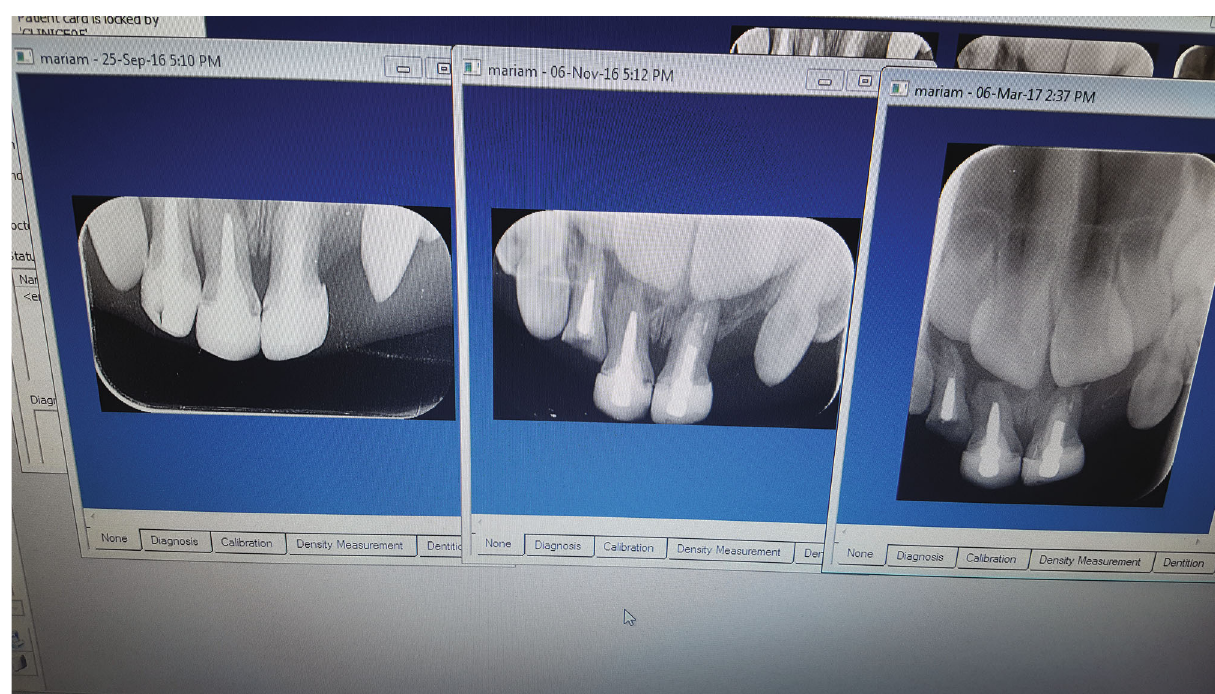
Figure 2: Radiographic follow-up of treated